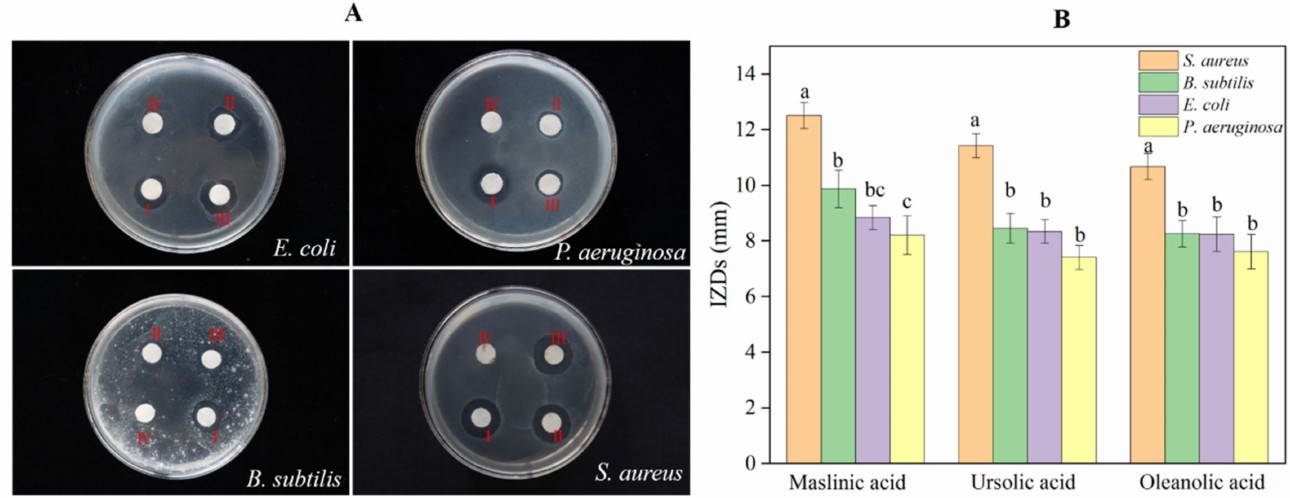
Figure 6. Antibacterial activity assay for OA, UA, and MA. ( A ) Bacteriostatic circles for 10 ug of: (I) MA; (II) OA; (III) UA; (IV) control, where 50% of DMSO was used as the control. These experiments were performed in triplicate. ( B ) The inhibition zone diameter. Values with different letters on the label are significantly different between bacteria against each compound ( p <